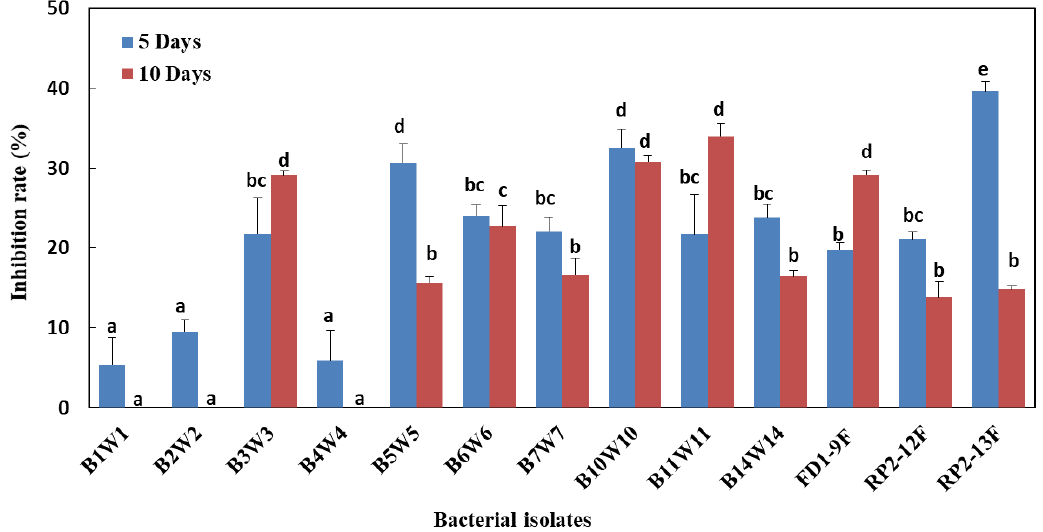
Figure 2. Inhibition rates of mycelial growth of M. fructigena obtained with volatile organic compounds of bacterial isolates (in dual distance bioassay). Data in the figure represent the mean of two independent trials with 4 replicates. In each incubation period, treatments having the same letter are not significantly different according to the LSD test ( p < 0.05).